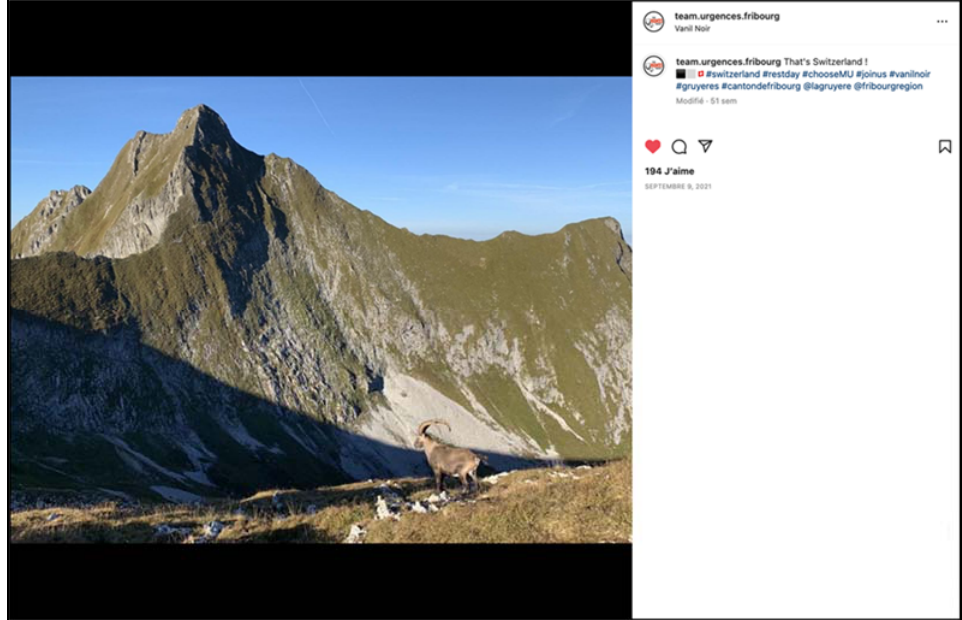
Figure 4. Highlighting the living environment which plays a major role in the recruitment of new employees: the Fribourg region in Switzerland offers many opportunities for extra ‐ professional activities (screenshot).